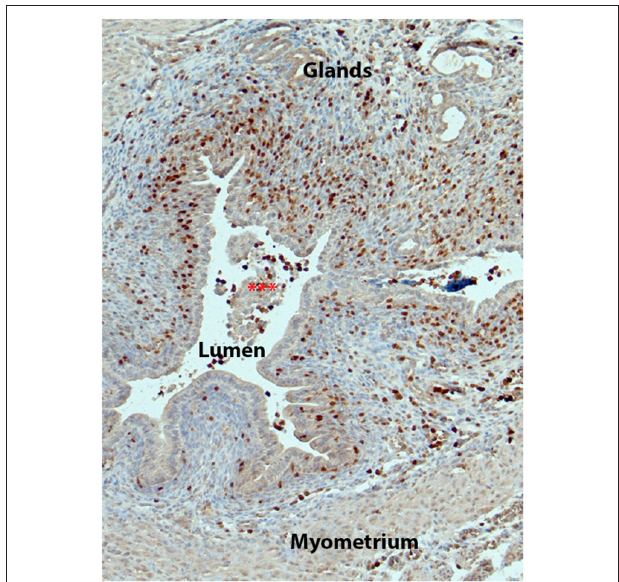
FIGURE 2 | Immune cells of the monocyte/macrophage lineage increase in the mouse endometrium during tissue breakdown. Figure shows endometrium from a Macgreen mouse 24h after progesterone withdrawal with immune cells identified by immunostaining of GFP (brown, fluorescent images of similar tissues are shown in (23)). Note that there are abundant GFP + cells in the stromal compartment with many adjacent to the newly intact luminal